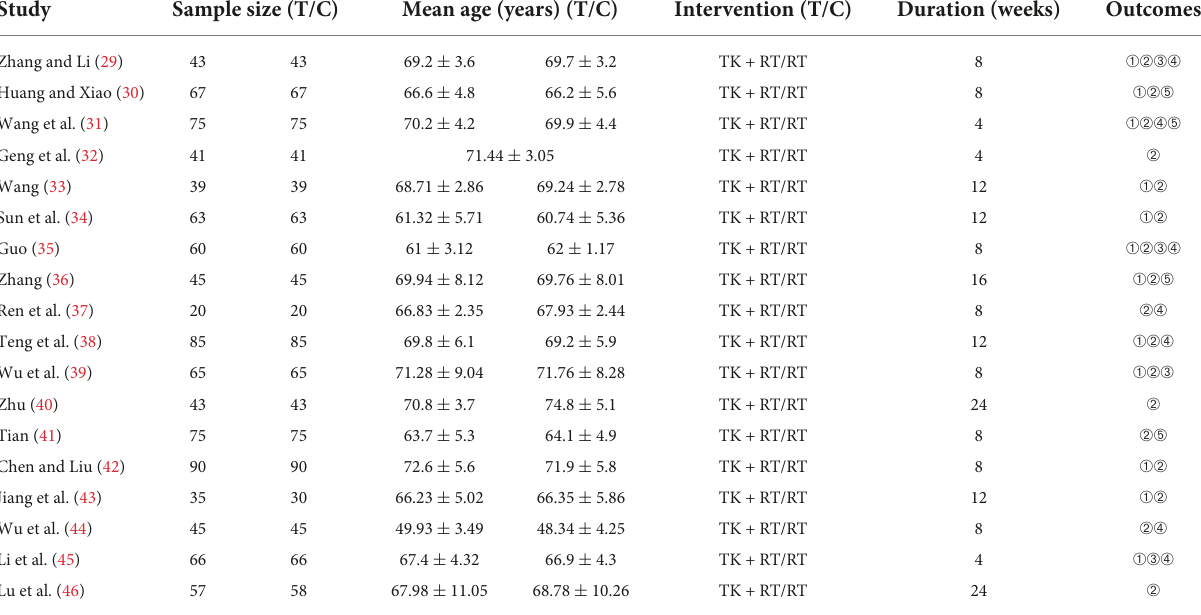
TABLE 1 Basic characteristics of included